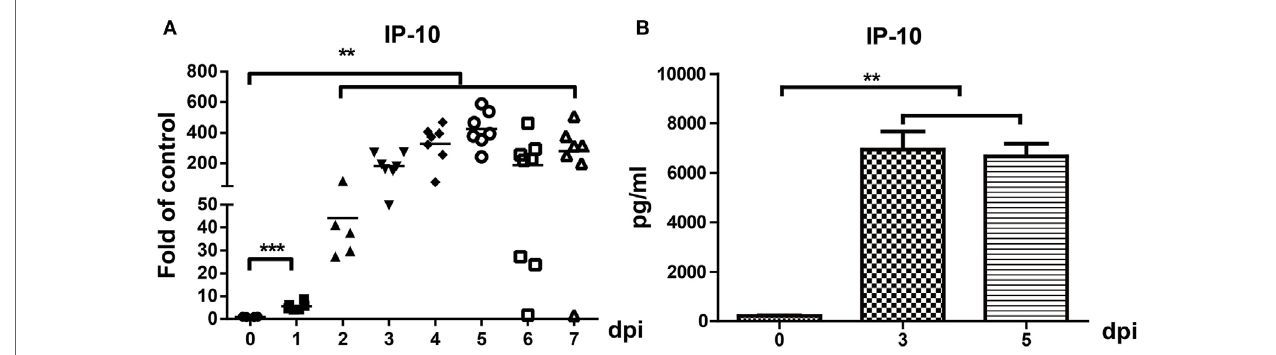
FigUre 1 | Expression of IP-10 in the central nervous system after Japanese encephalitis virus (JEV) infection. Mice were intravenously injected with 10 5 plaque-forming units of JEV-P3. (a) IP-10 mRNA expression was determined via quantitative real-time PCR from 0–7 dpi, and the results show the fold-change of IP-10 relative to the control ( n = 6). (B) IP-10 was detected with enzyme-linked immunosorbent assay on days 0, 3, and 5 ( n = 4). The results reflect the means ± SEMs from two independent experiments. ** p < 0.01; *** p <